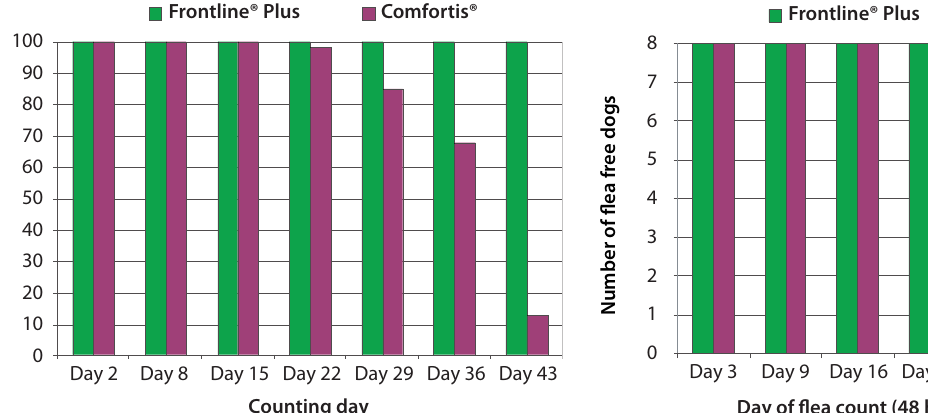
Fig 1. – Comparative % of adult flea efficacy in the two treated groups at 24 hours counts.